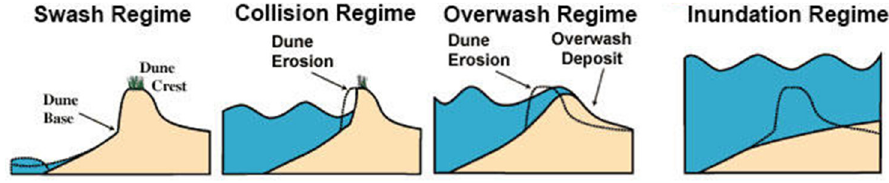
Figure 3. Schematic of storm impact regimes.